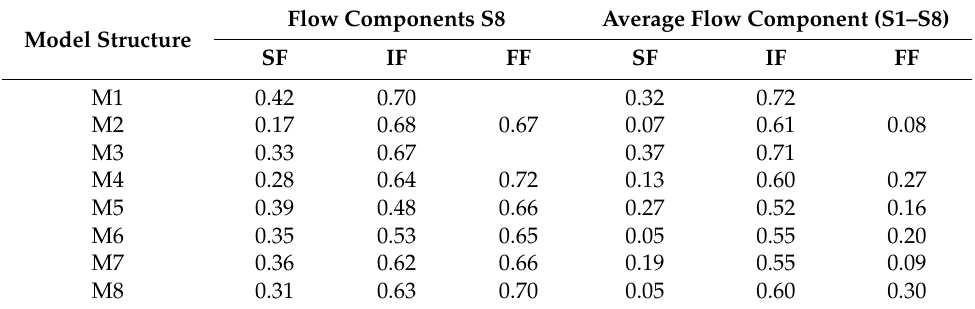
Table 5. Nash–Sutcliffe efficiency for simulated flow components from each model structure. For outlet subcatchment S8 and the average of